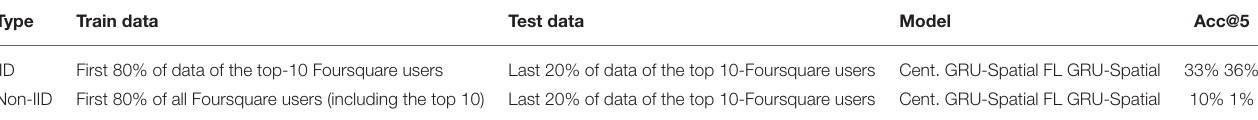
TABLE 6 | IID vs. non-IID experimental